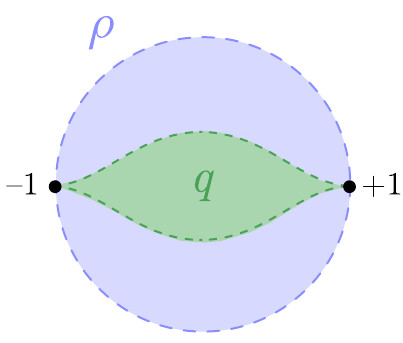
Figure 6. Relation between the radial ρ variable and the new coordinate q